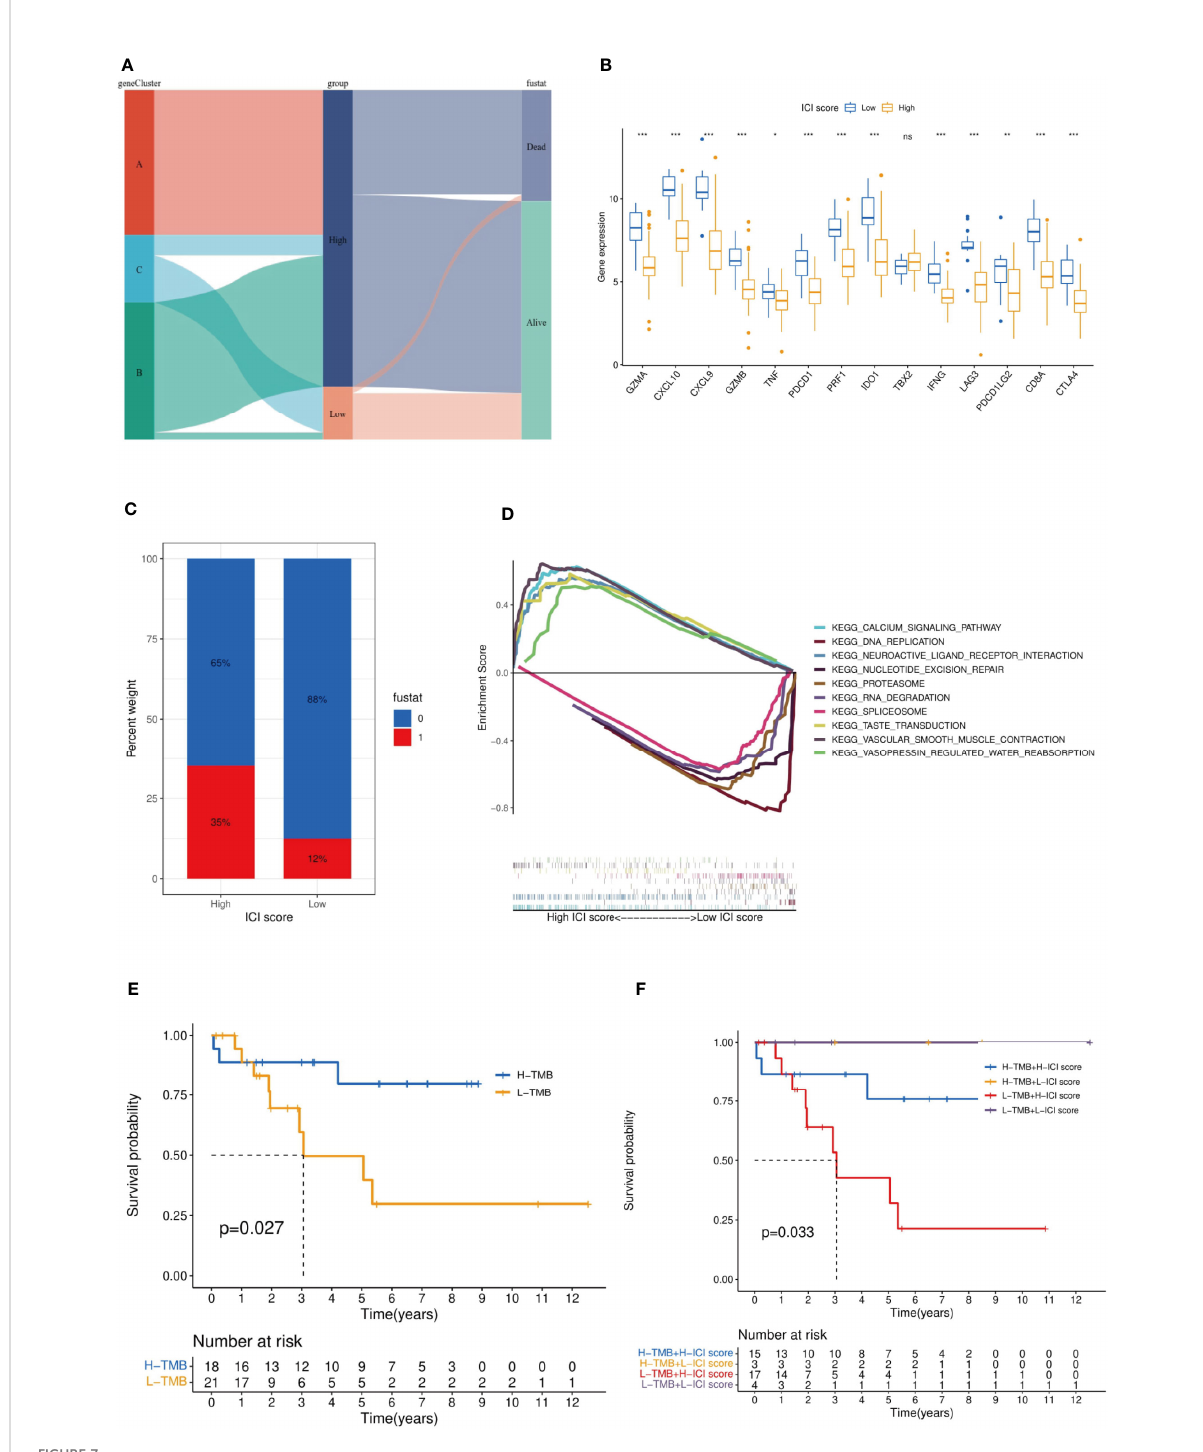
FIGURE 7 Established and veri fi ed the ICI score. (A) The relationship among gene clusters, ICI high or low groups and survival outcomes is visualized in a Sankey diagram. (B) Based on the ICI score, we analyzed the expression difference among the immune checkpoint genes and immune- activating genes. It should be noted that PDCD1LG2 is another name for PD-L2. (C) Effect of ICI score on patient survival. (D) GSEA indicated signi fi cantly enriched signaling pathways corresponding to high and low ICI score groups. (E) Survival analysis was performed by TMB score in our selected MFS samples. (F) MFS samples were strati fi ed by TMB score and the ICI score established in this study. ***p<0.001,**p<0.01, *p<0.05 and ns p>0.05, no signi fi